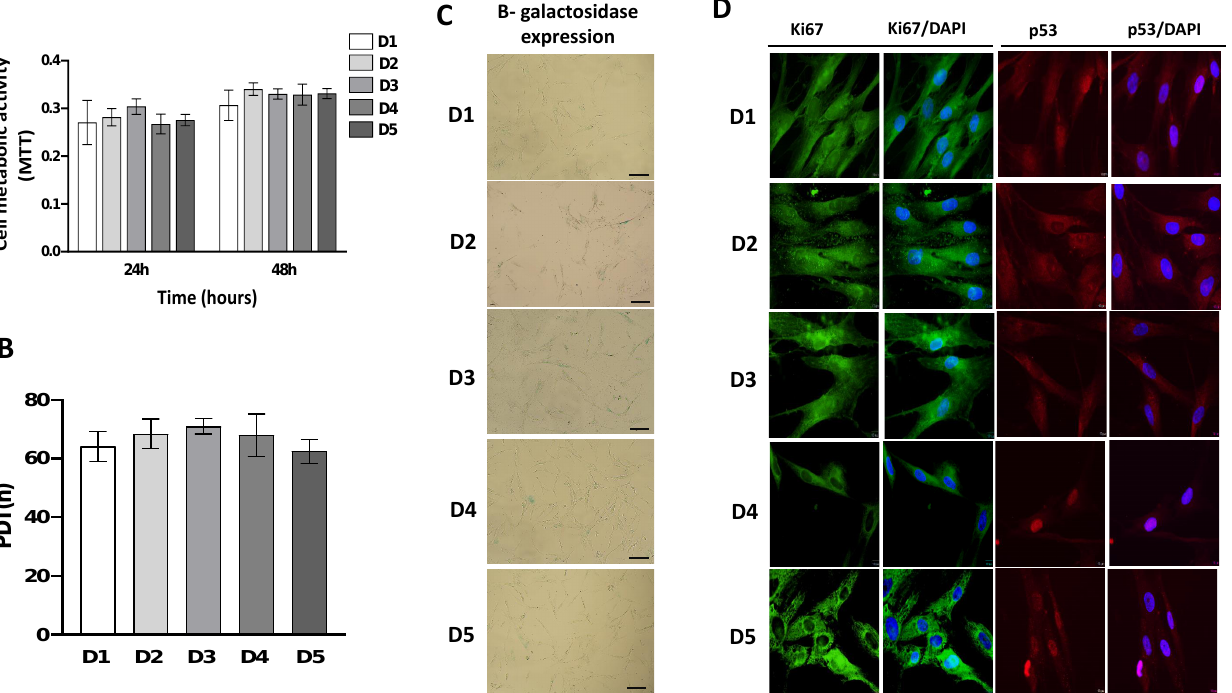
Figure 4. Growth characteristics of BM-MSCs. ( A ) Metabolic activity of cells isolated from 5 donors during 24 h and 48 h estimated by MTT test. ( B ) Population doubling time (PDT) of BM-MSCs. Cells were cultivated in standard conditions, passaged at 90% confluency, and enumerated at each passage (up to 6th passage). For PDTs calculation, the formula described in Material and Methods was applied. Results on the graph are presented as ± SEM of independent experiments. ( C ) Representative images of BM-MSCs stained for β -galactosidase expression after one day of cul- tivation under standard conditions (scale bar: 50 µ M). ( D ) Expression of proliferation-associated marker Ki67 and p53 detected by indirect immunofluorescence labeling with corresponding FITC- conjugated or AlexaFlour555-conjugated secondary antibodies. Cell nuclei were stained with DAPI (4 (cid:48) ,6-diamidino-2-phenylindole). Representative images are shown (scale bars: 10 µ